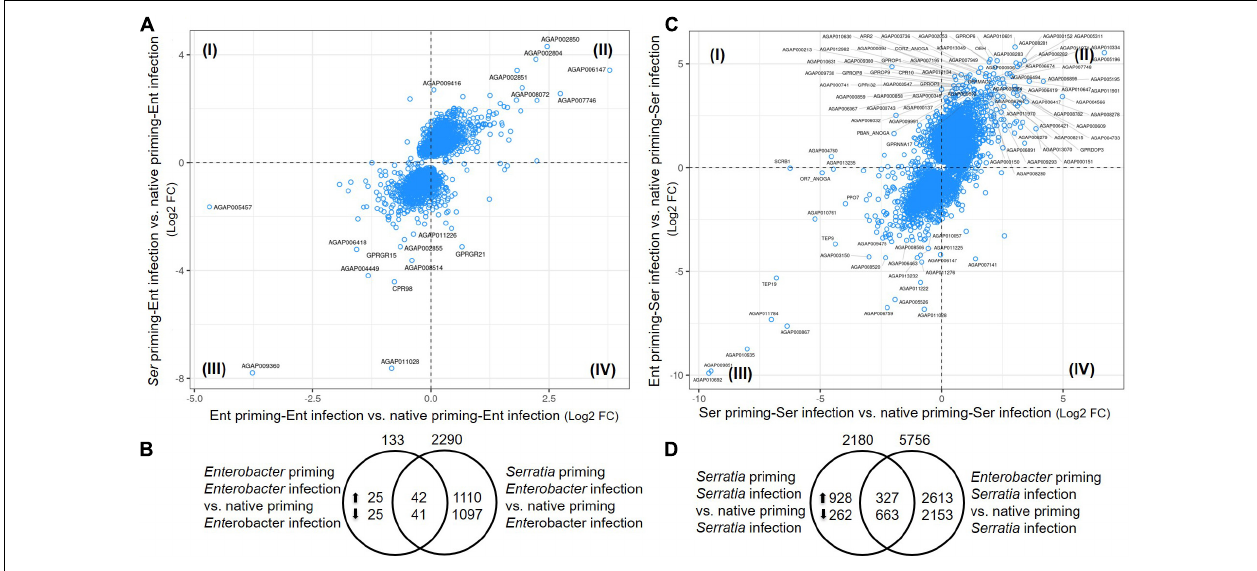
FIGURE 7 | Priming effects on transcriptional response to bacterial challenge. (A,C) Comparison between the cohort with Enterobacter or Serratia priming vs. the cohort with native microbiota. Plotted are genes with q -value < 0.05 in either comparison to cohort with native microbiota. Labeled genes have log 2 fold change in either comparison > 2.5 or < –2.5 in (A) and > 3.5 or < –3.5 in (C) . The genes in quadrant I and IV were the genes differentially expressed upon different priming regimes. (B,D) Distribution of the genes that were altered by priming. Total number of altered genes is placed on top of the circle, number of up- or down-regulated genes were specified inside the circle. The genes in the central area were shared by both cohorts with respective